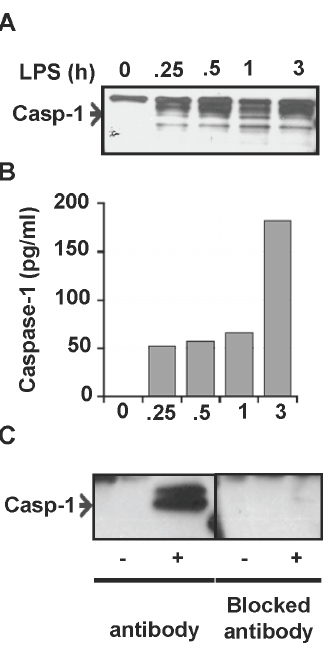
Figure 4. Release of caspase-1 in microvesicles from endotoxin stimulated whole blood. Whole blood was stimulated with LPS for different times (0, 0.25, 0.5, 1 and 3 h) and microvesicles were isolated from the plasma of the stimulated blood. Caspase-1 was detected in the microvesicles by immunoblot ( A ) and ELISA ( B ). To show specificity, caspase-1 detection was also performed after blocking the antisera with excess recombinant caspase-1 before immunoblot ( C ).